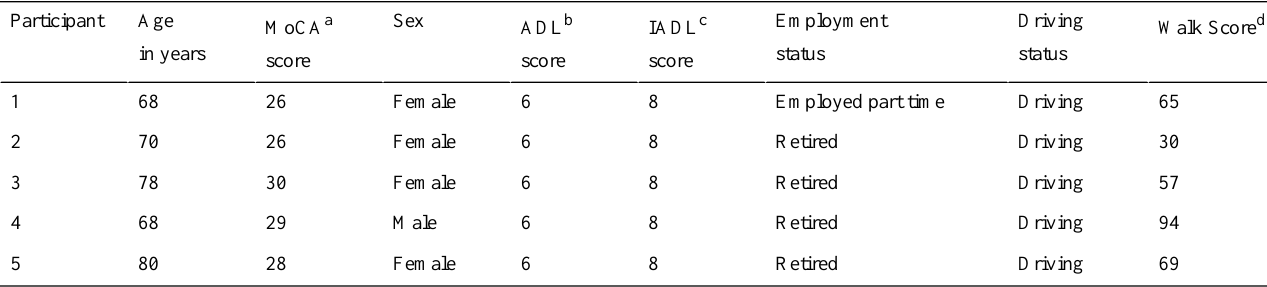
Table 4. Sample demographic characteristics.